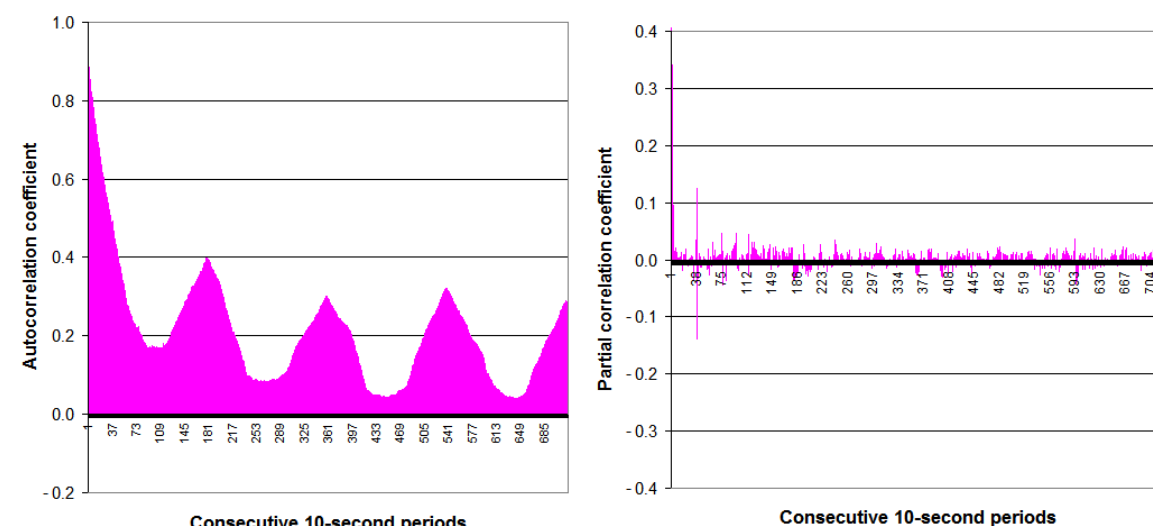
Figure 6. Autocorrelation function (ACF) and partial autocorrelation function (PACF) of the second time series in the analyzed December day.